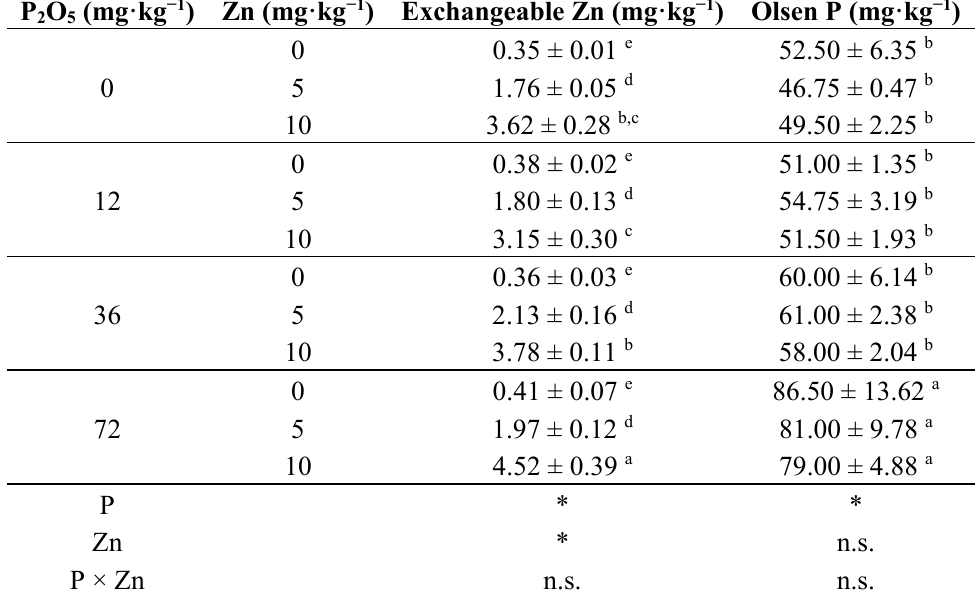
Table 7. Effect of zinc and phosphorus supply on residual soil content of exchangeable zinc (DTPA Extraction) and assimilable phosphorus (Olsen) after